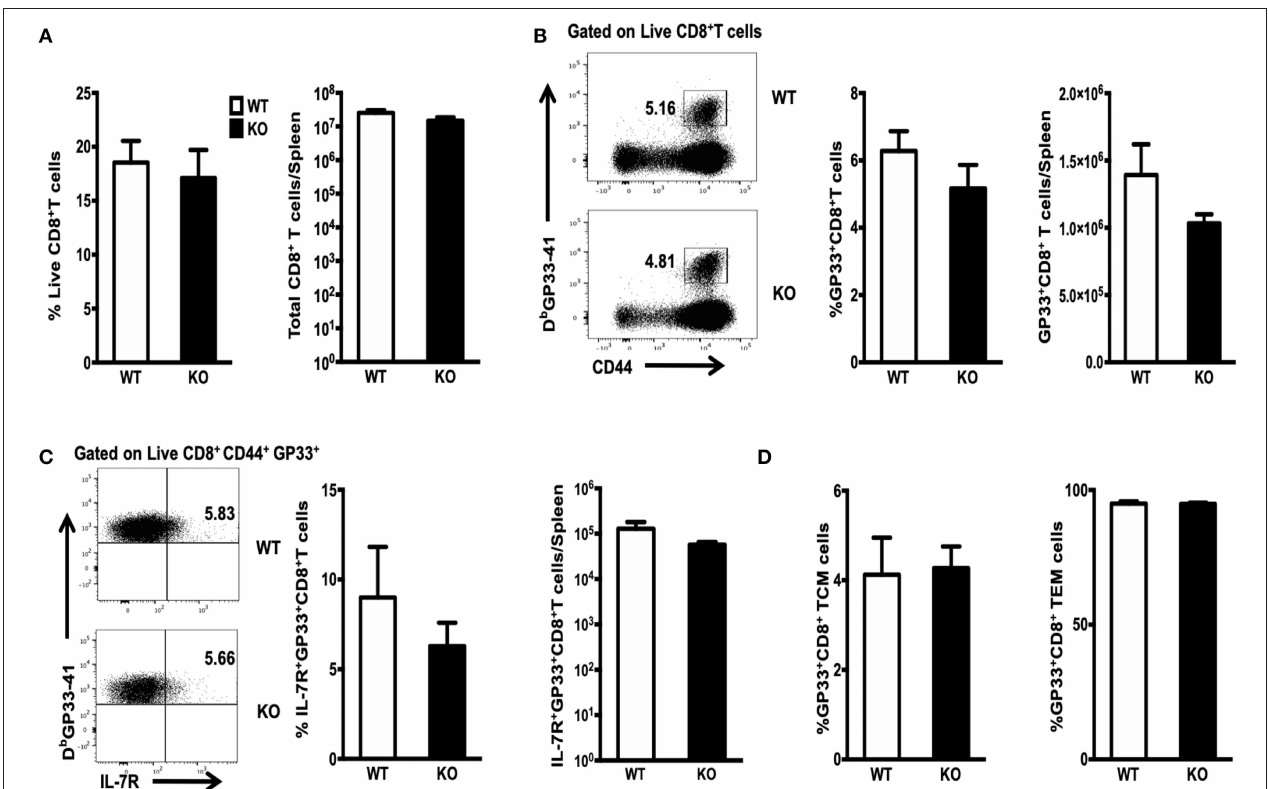
FIGURE 1 | Efficient clonal expansion and effector differentiation of WASp-deficient CD8 + T cells. WT and WASp − / − mice were infected with LCMV and the number of GP33-specific CD8T cells in the spleen on 8 days PI was quantified by staining with an anti-CD8 antibody and D b /GP33 tetramers. Bar graphs in (A) illustrate the percentage (left panel) and absolute number of CD8 + T cells (right panel) in the spleen on Day 8 PI. (B) Flow cytometry analysis of spleenocytes from WT and WASp − / − mice; numbers indicate the percentage of GP33-specific cells within the CD8 + T cell population (left panel) and the histogram show the percentage of GP33-specific T cells within CD8 + T cells (middle panel) and the absolute number of GP33-specific CD8 + T cells (right panel) in the spleen on Day 8 PI. (C) Representative data showing expression of IL-7R on GP33 specific CD8 + T cells (left panel); Percentages of IL-7R + cells within the GP33-specific CD8 + T cell population (middle panel) and the absolute number of IL-7R + GP33-specific CD8 + T cells (right panel) in spleen on Day 8 PI. (D) The proportion of TCM (left panel) and TEM (right panel) within the GP33-specific CD8 + T cell population was determined by measuring expression of CD62L. Data are expressed as the mean ± SEM and are representative of at least two independent experiments, each with 5 mice per group. Data were analyzed using an unpaired t